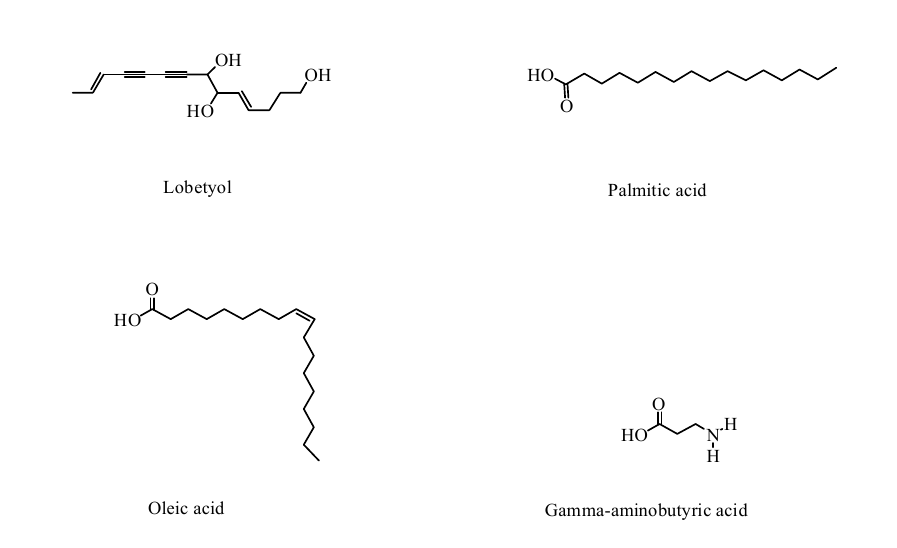
Figure 4. Other active components in P. grandiflorus. Table 2. The others components isolated from P. grandiflorus.